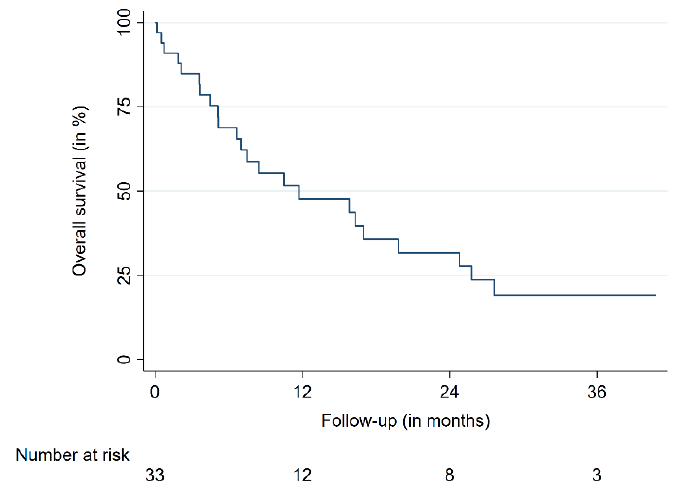
Figure 2. Overall survival.